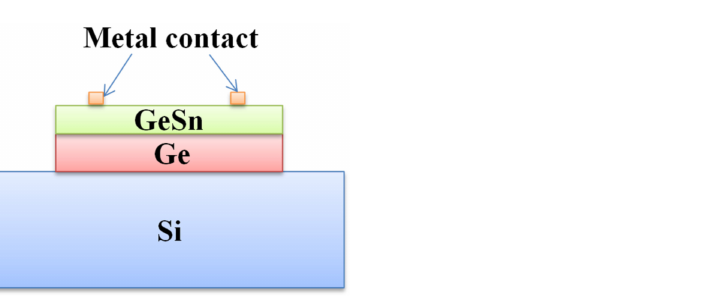
Figure 16. Cross-sectional schematic of a device structure for a GeSn photoconductive